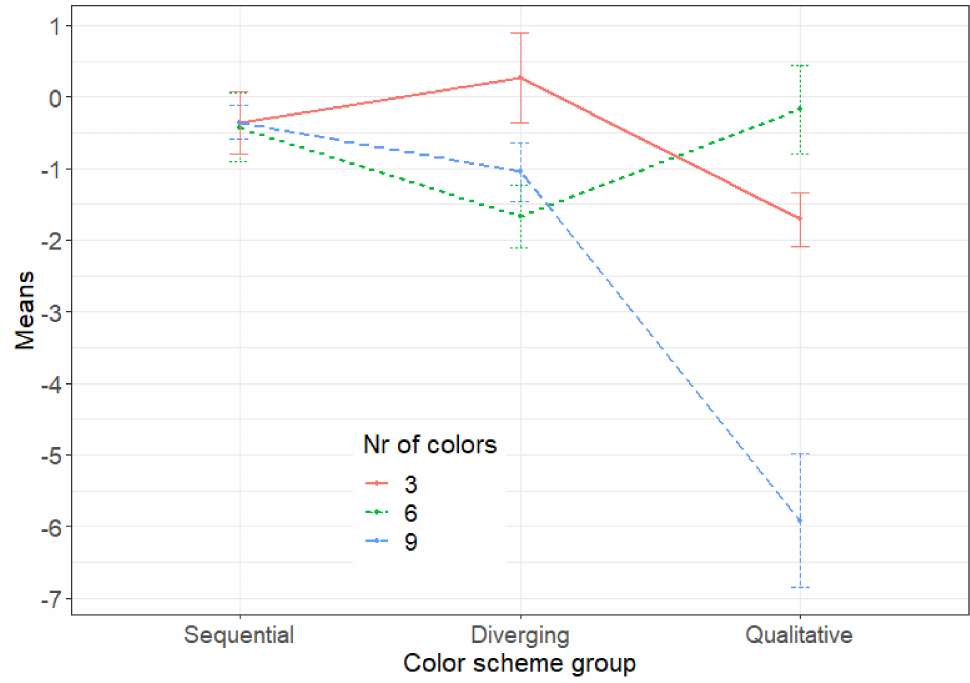
Figure 11. Interaction plot of the error means for different color scheme groups and numbers of colors.